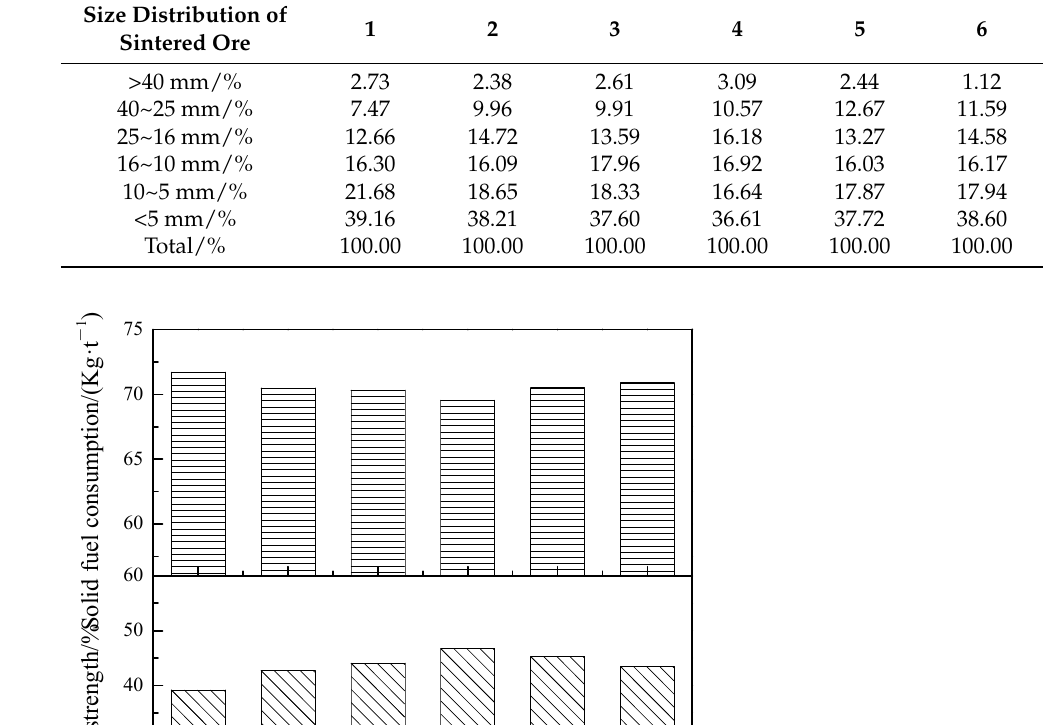
Table 7. Effect of different layer height proportions and ignition time interval on the size composition of sintered ores.